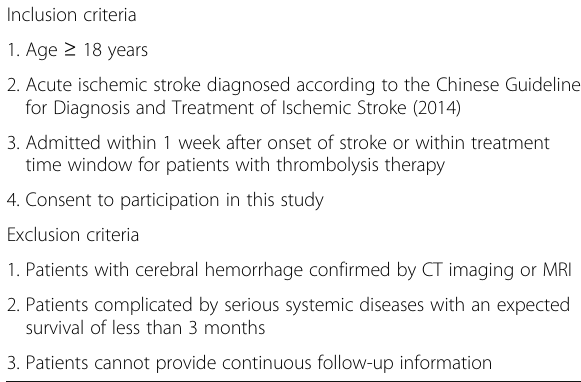
Table 1 Inclusion and Exclusion